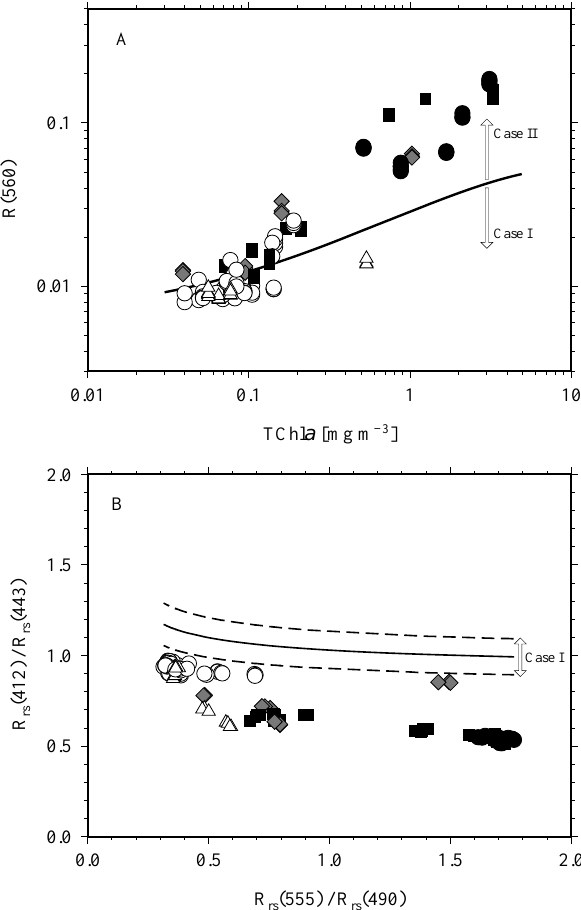
Fig. 5. (A) Irradiance reflectance at 560nm, R( 560 ) , as a func- tion of the Chl a concentration. The curve corresponds to the the- oretical limit between case-1 and case-2 waters, computed from Chl a following Morel and B´elanger (2006). (B) R rs (412)/ R rs (443) as a function of R rs (555)/ R rs (490). The solid line corresponds to Eq. (2a) in Lee and Hu (2006), and the dashed curves to ± 10% around this